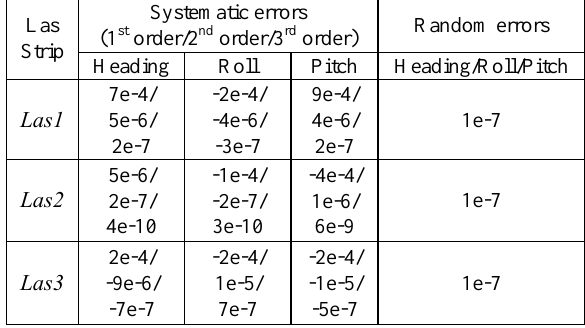
Table 1. Systematic and random errors added to the POS data of 3 LiDAR strips (unit: